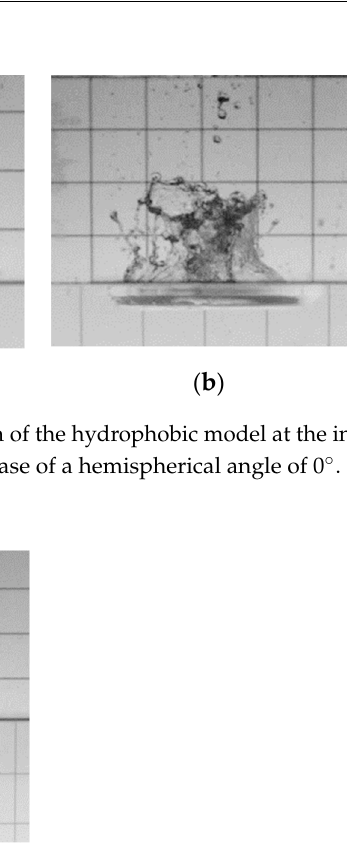
are ignored, and the diameter at the highest point is taken as the splash diameter. At shape of the primary splash, the splash height and diameter are measured until the splash closes. The curves of the splash height and diameter over time under the hydrophobic conditions are shown in Figure 19.